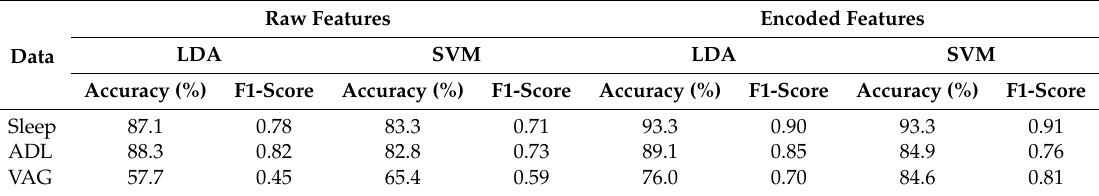
Table 5. Machine Learning Results along F1-Scores for each actigraphy dataset.